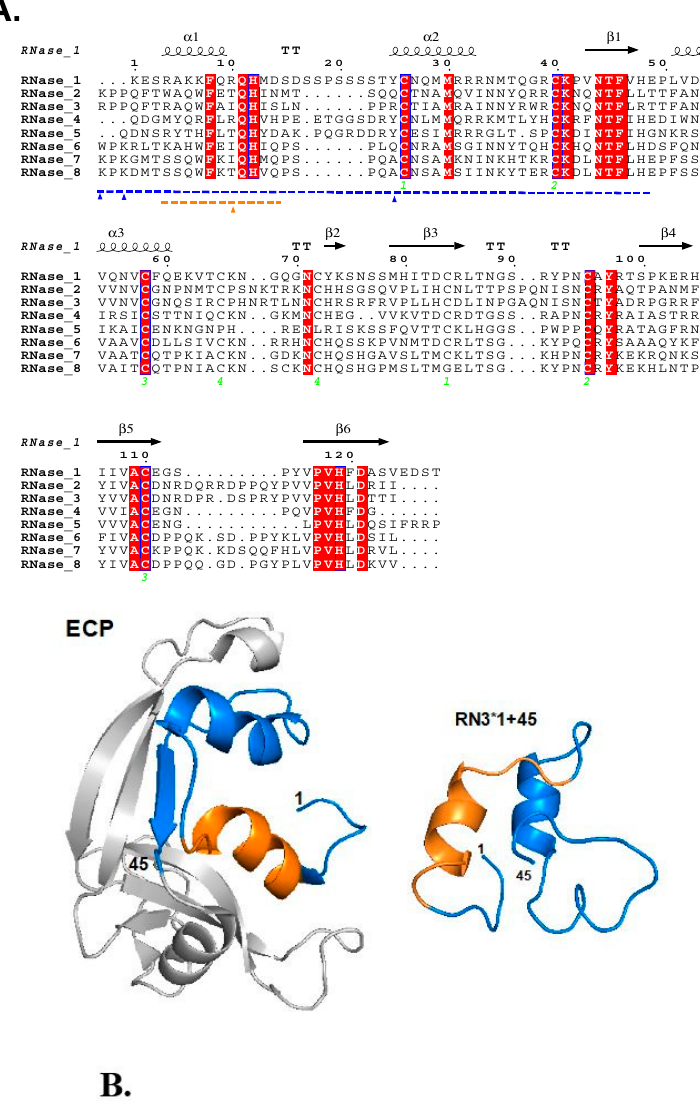
Figure 1. ( A ) Sequence alignment of hRNases. Conserved regions are boxed; highly conserved amino acids are colored in white over a red background, whereas moderately conserved amino acids regions are colored in red. The secondary structure of hRNase3 is displayed as a reference on top of the alignment. The N-terminal antimicrobial domain is highlighted in blue and the agglutination-promoting region in orange. ( B ) The tertiary structure of Eosinophil cationic protein (ECP), the N-terminal domain is colored according to the antimicrobial (blue) and aggregation (orange) properties (PDB code 4A2O). Right hand: Model representation of RN3 1–45, the figure was performed by PEP-FOLD3 (http://mobyle.rpbs.univ-paris-diderot.fr/cgi-bin/portal.py#forms::PEP-FOLD3).